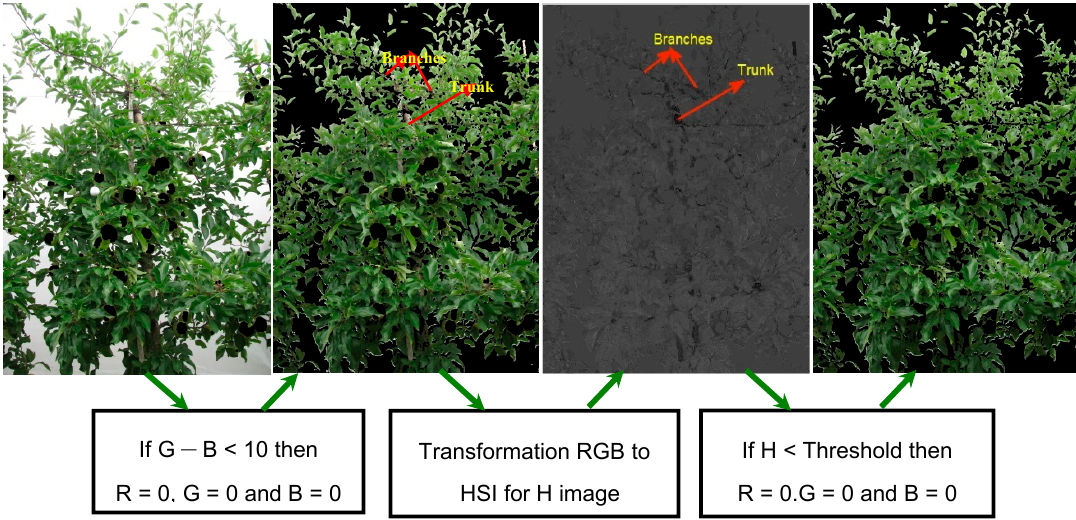
Figure 4. Proposed algorithm for leaf discrimination; an example of image processing.